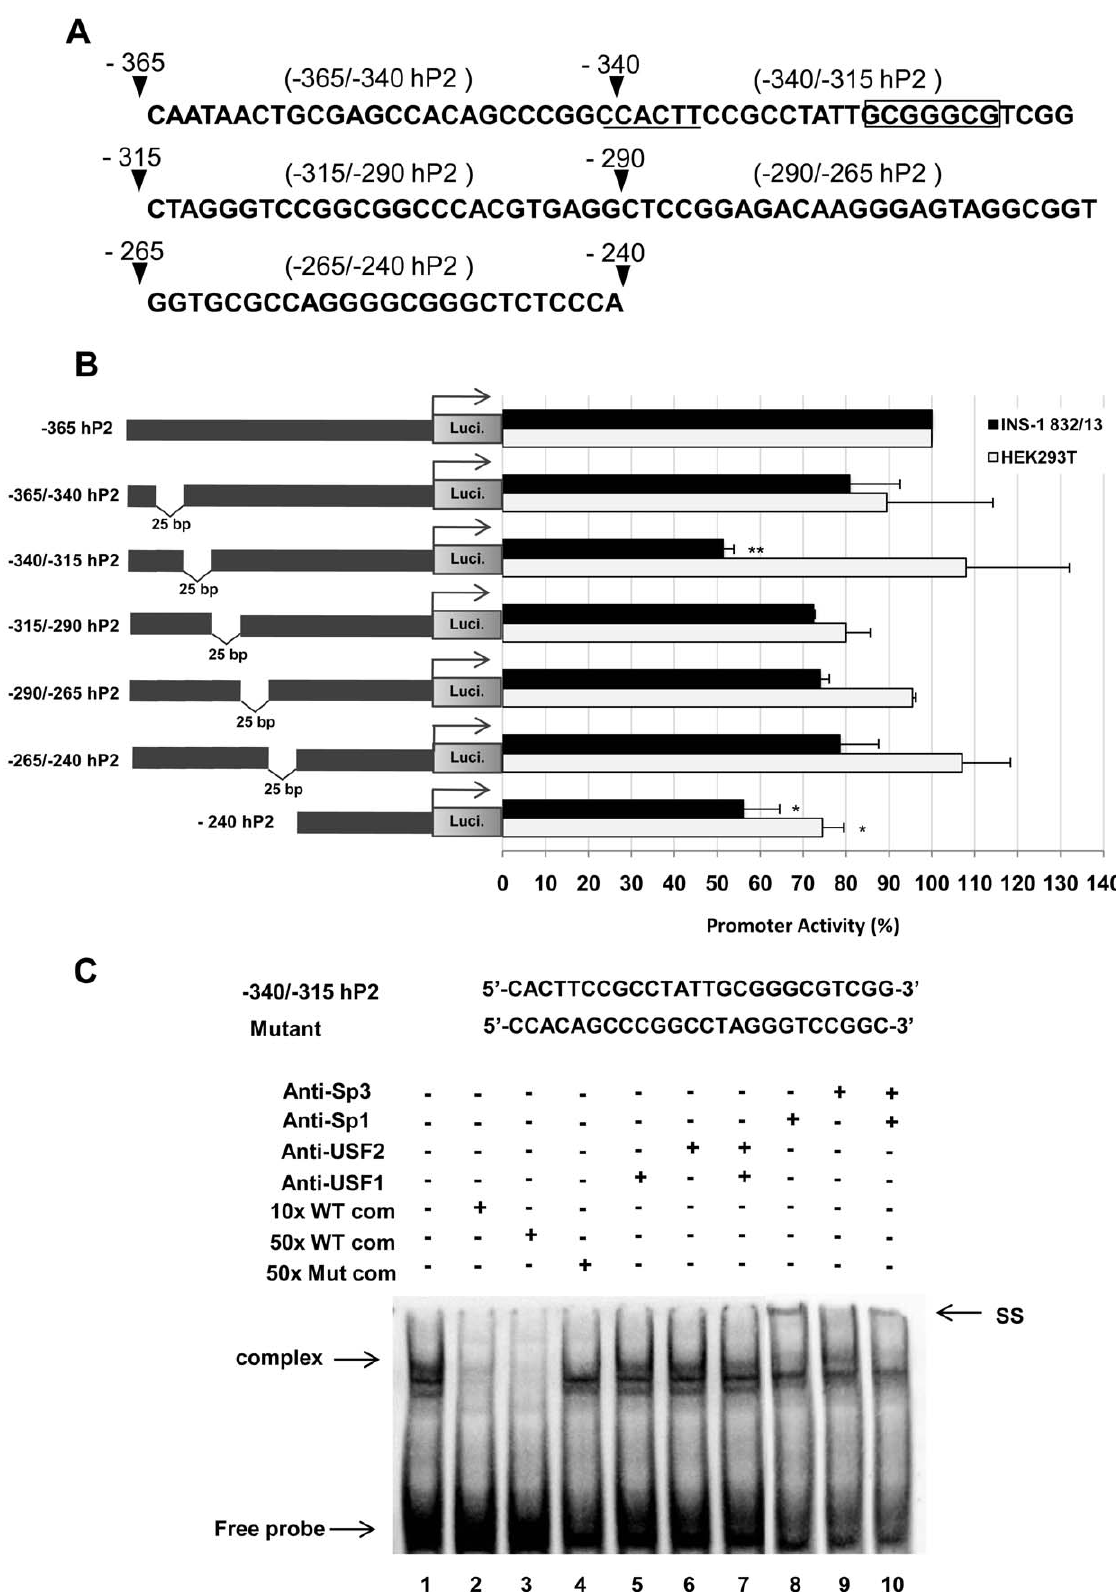
Figure 5. Identification of positive regulatory element(s) located between 2 365 and 2 240 of the human PC P2 promoter. (A) Schematic diagram of 15 bp internal deletions of 2 114/ 2 39 the human PC P2 promoter. (B) Transient transfections of a series of 25 bp internal deletion constructs into the INS-1 832/13 cell line and non-beta cell HEK293T cell line were performed to identify the positive regulatory sequences in